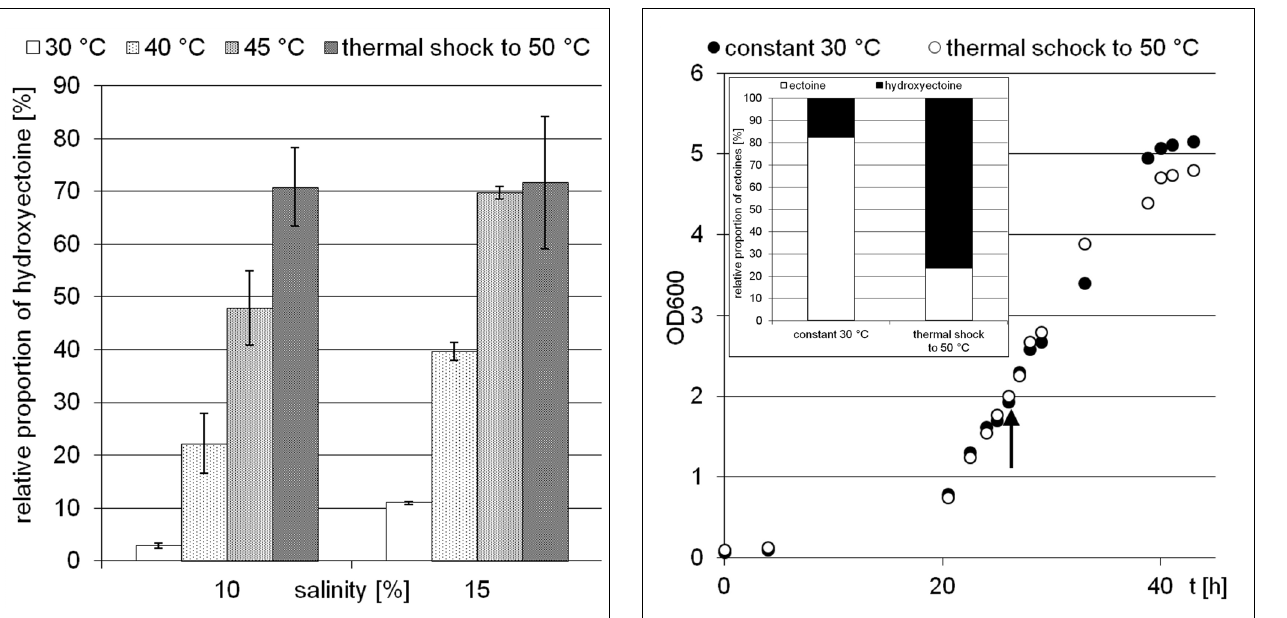
DRY STABILIZATION OF H. elongata CELLS AT ELEVATED HYDROXYECTOINE LEVELS